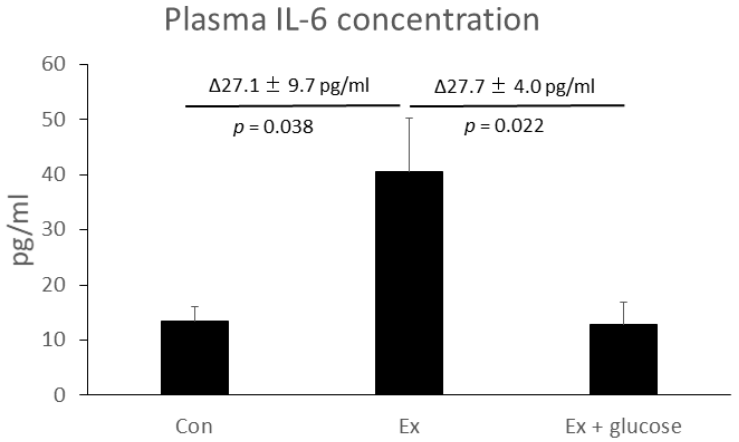
Figure 1. Effects of exercise and glucose ingestion on plasma Interleukin (IL)-6 concentration. The data are presented as means ± standard error (SE). The differences in IL-6 concentration between Ex and Con or Ex + glucose are presented Δ means ± SE above the bar. p -values for the differences between Ex and Con or Ex + glucose are presented below the bar.